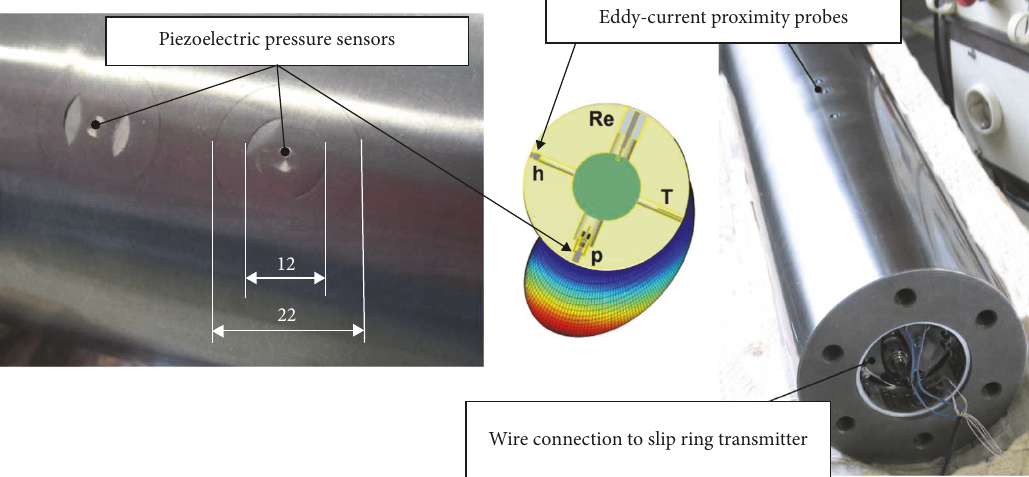
Figure 15: Rotor-sided applied sensors [11].